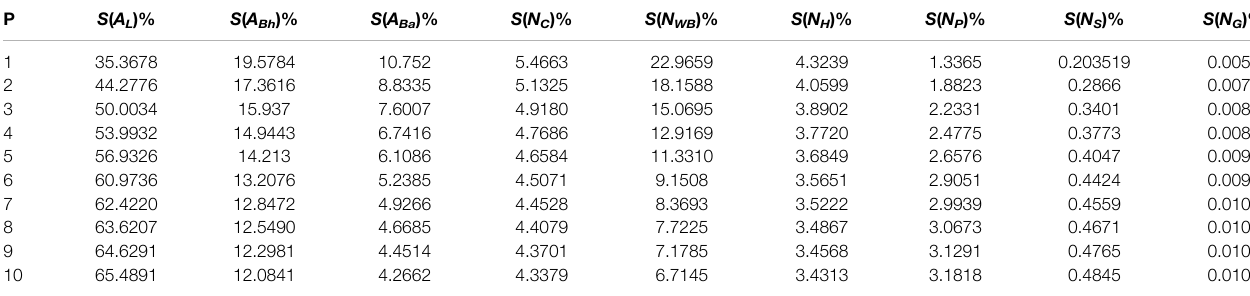
Table 3 . The shares in the total wealth of the different categories, as it was discussed for 1961, are presented in Table 4 .